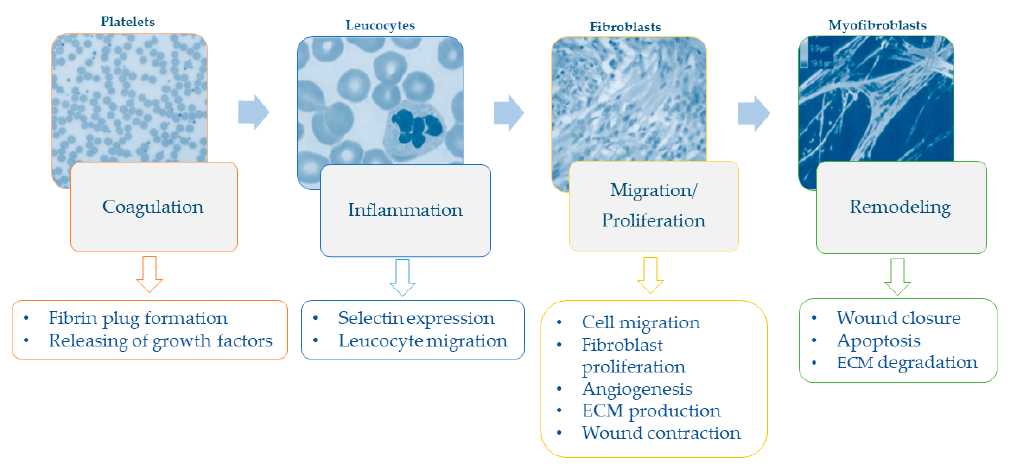
Figure 2. Phases and specific events of the wound healing process.